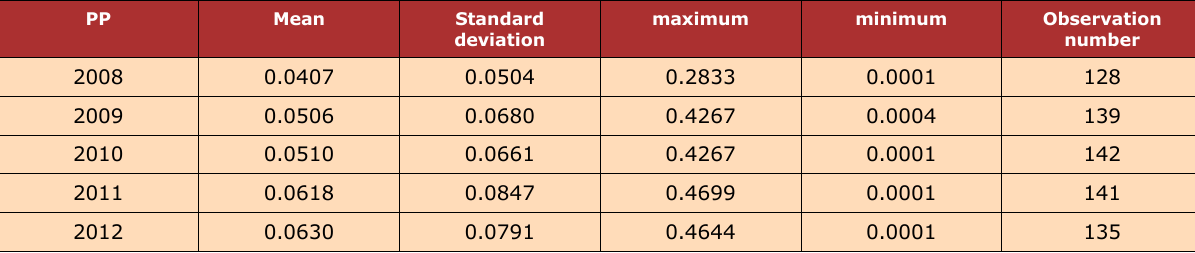
Table 2. Statistical results of corporate environmental propensity in heavy-pollution